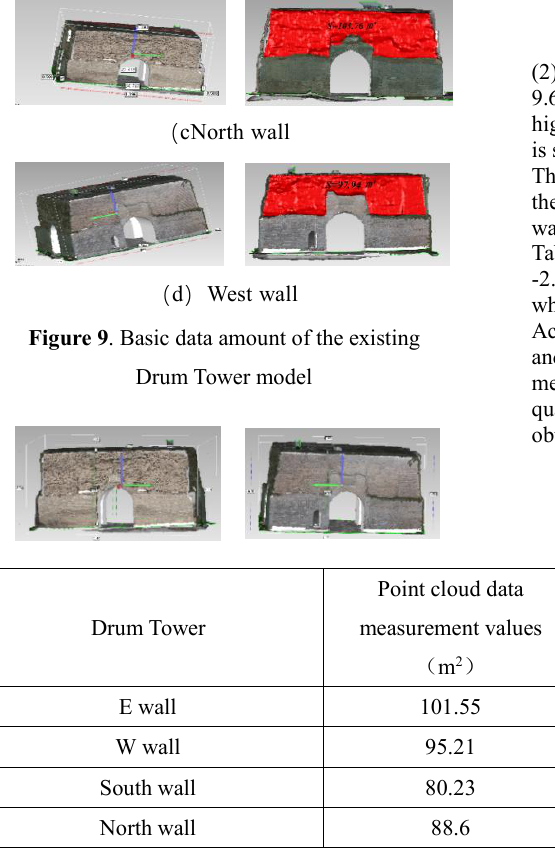
Table 2 Compare the original data with the measurement data of the established model